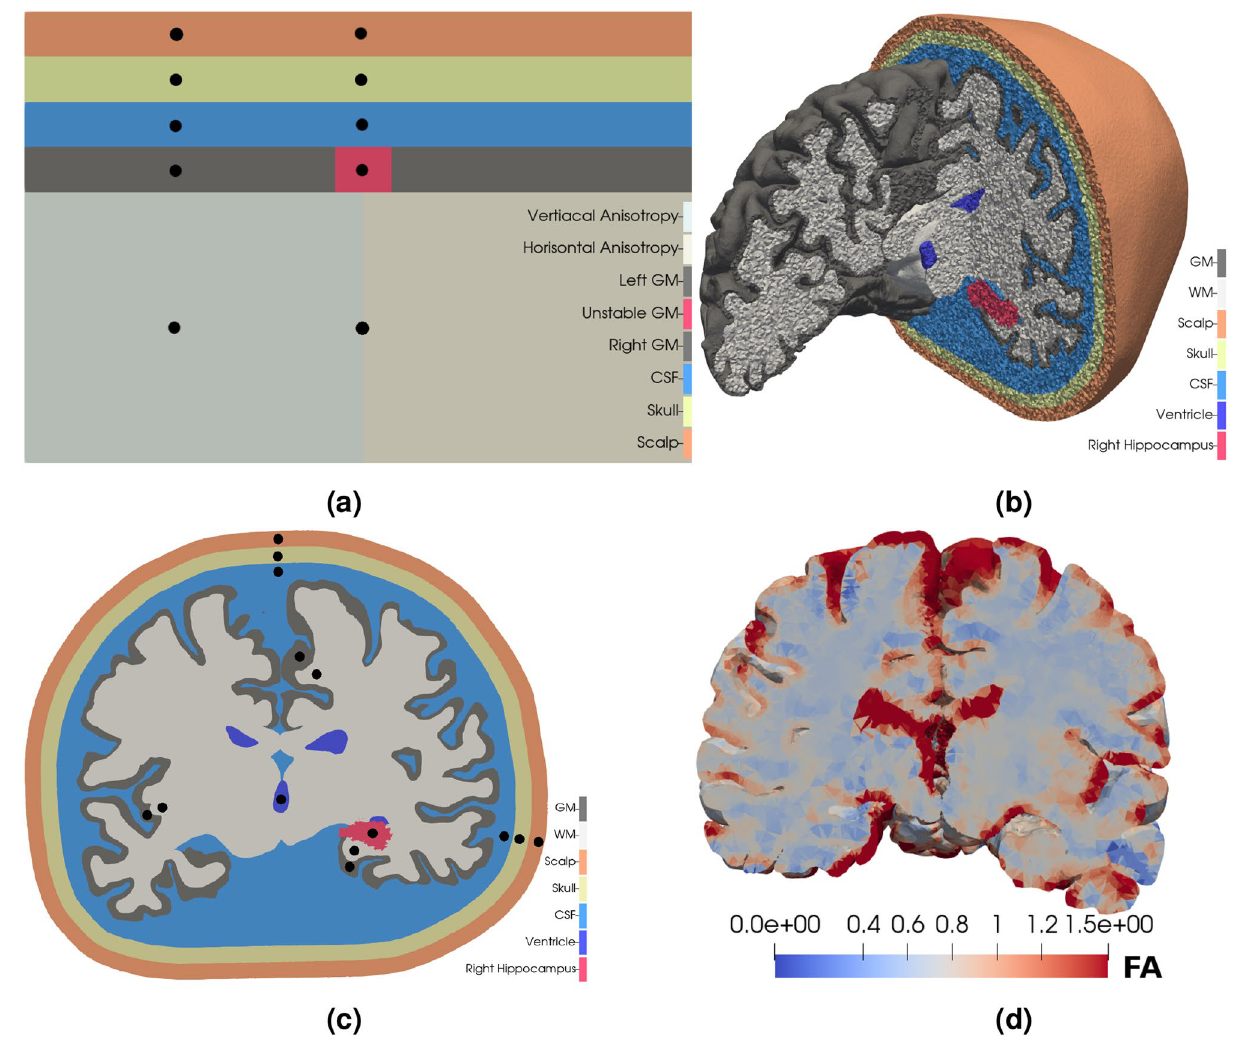
Figure 1. Computational geometries ( a ) An idealised two-dimensional model of a slice of the head with, from the top, scalp (orange), skull (yellow/pale green), cerebrospinal fluid (blue), grey matter (dark grey and red), and white matter (two shades of light grey). The central grey matter (red) is modelled by an unstable neuronal model, Model B, while the rest of the grey matter (dark grey) is modelled by a stable neuronal model, model A. The conductivity is isotropic, except in the white matter. The anisotropic conductivity tensor in the white matter is oriented vertically in the left part and horizontally in the right part. The simulated electric potential is measured at locations marked by black dots ( b ) The three-dimensional patient specific head model. The colours are the same as in ( a ), however, the ventricles are marked dark blue, and the right hippocampus is marked in red. Note that the ventricles are modelled the same way as the cerebrospinal fluid. As in ( a ), the grey matter is modelled by Model A, while the right hippocampus is modelled by Model B. ( c ) A slice of the head model in ( b ). The simulated electric potential is measured at locations marked by the black dots. ( d ) The mean diffusivity is highest in the ventricles and the cerebrospinal fluid, both showing up in red. The mean diffusivity is 1 / 3 Tr ( M ) , where M is the conductivity tensor. The conductivities are measured in mS / cm